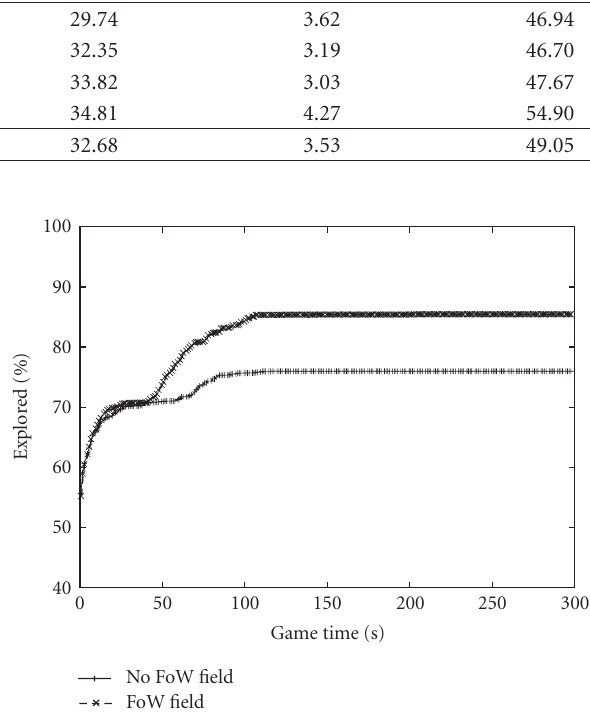
Figure 8: The average explored area given the current game time for a bot using the field of exploration, compared to one that does not. Table 9: Performance of the bot with and without field of exploration in 20 matches against